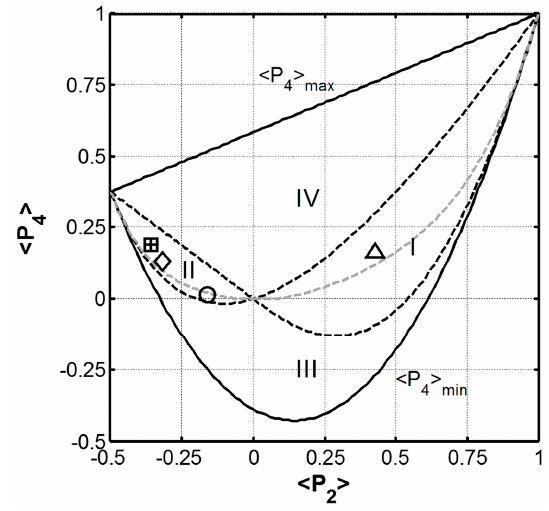
Figure 5. The graph of the limiting values of ‹ P 4 › as a function of ‹ P 2 ›. The (‹ P 2 ›, ‹ P 4 ›) couple determined for B. terrestris ( ∆ ), A. Illawarra ( ○ ) fibres are presented along with those of B. mori (+) and S. c. ricini for B. terrestris ( ∆ ), A. Illawarra ( ) fibres are presented along with those of B. mori (+) and S. c. ricini ( ˝ ) ( □ ) cocoon silks and N. edulis ( ◊ ) dragline silk [13,15]. Note that the values determined for B. mori (cid:35) cocoon silks and N. edulis ( ♦ ) dragline silk [13,15]. Note that the values determined for B. mori cocoon and S. c. ricini cocoon overlap. The dashed grey line represents the values of ‹ P 4 › when λ 4 = 0. A third locus of points arises out of the Shannon’s entropy treatment of the orientation distribution function (Equations (5) and (6)) when λ 4 is set equal to zero [41]. This line is also shown as the dashed grey line in Figure 5 and corresponds to a function that is unimodal and Gaussian. The